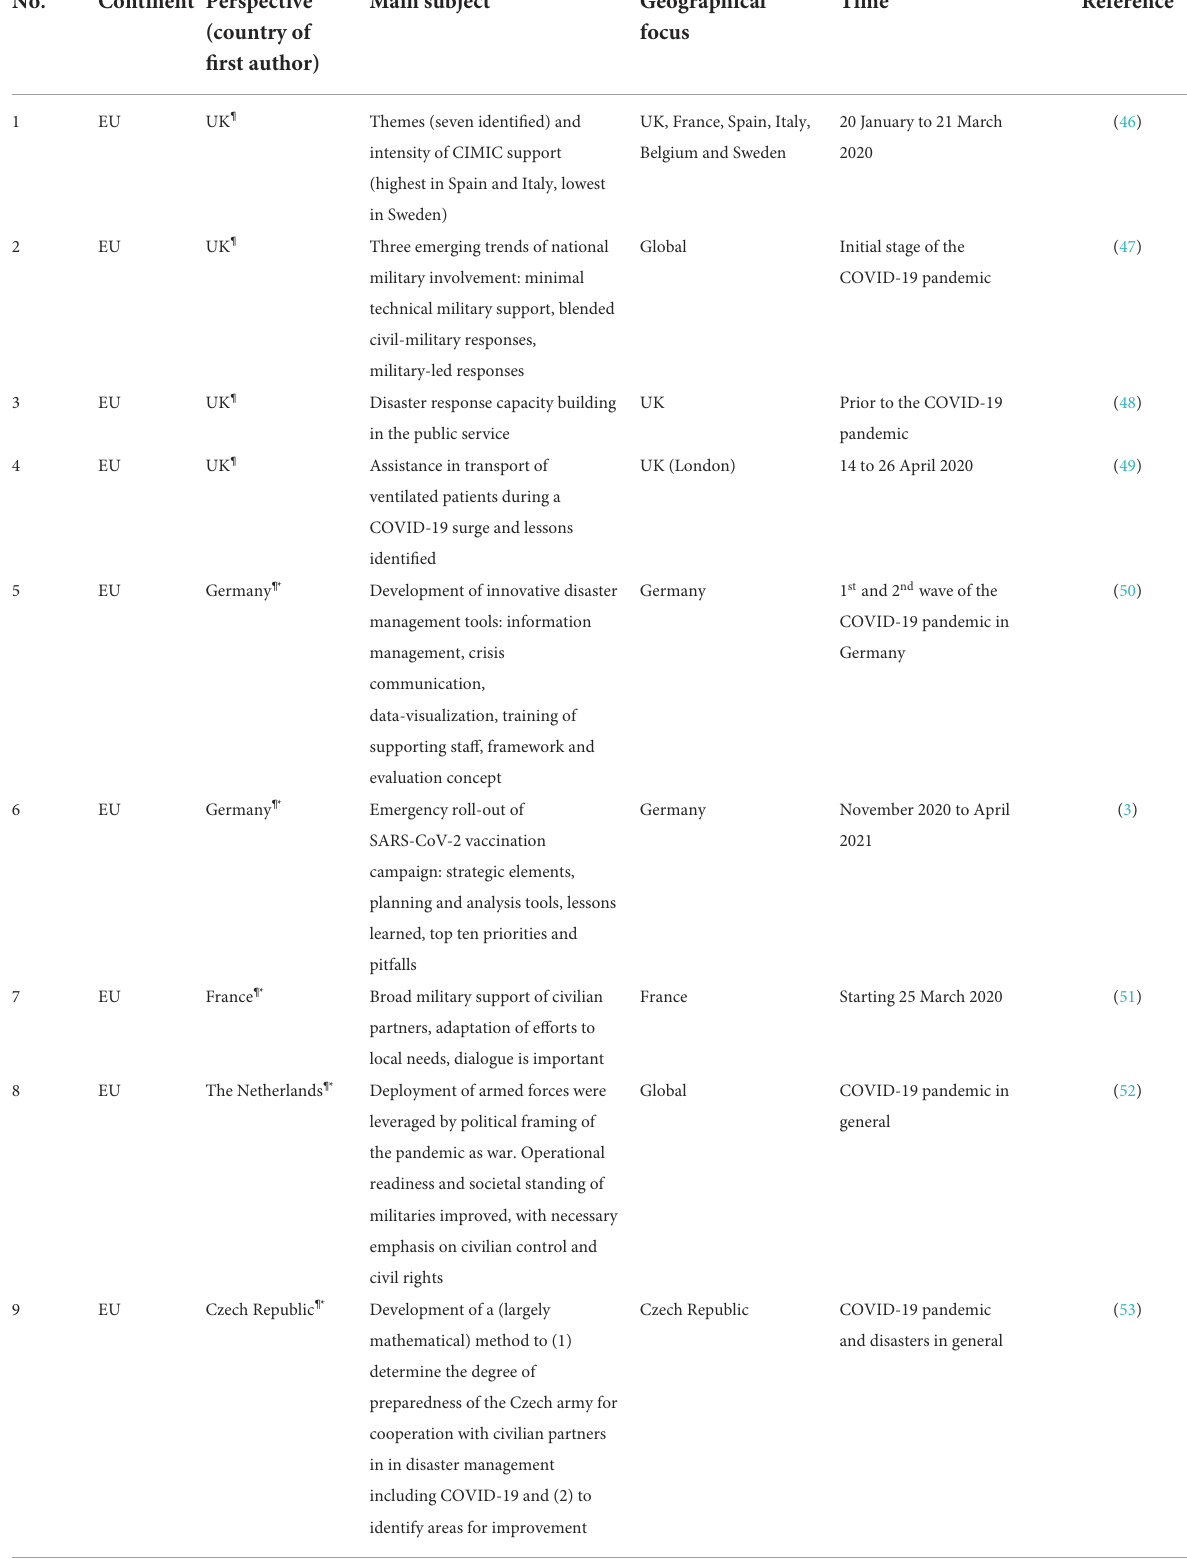
TABLE 3 Synopsis of CIMIC experiences reported in the global academic literature.